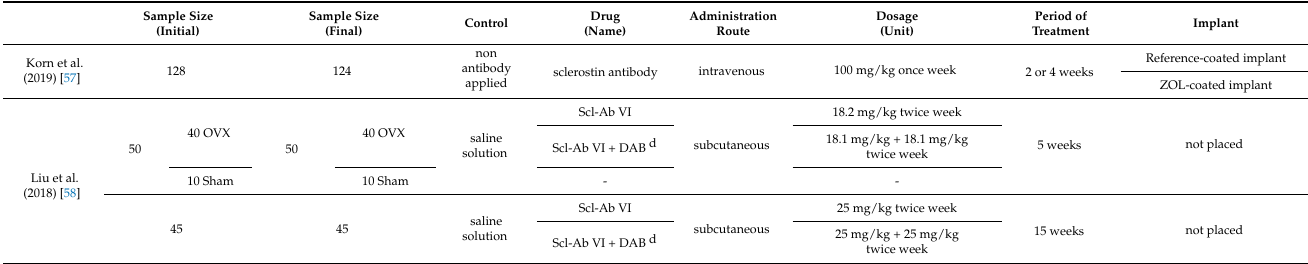
Table 2. Main characteristics of selected articles—part